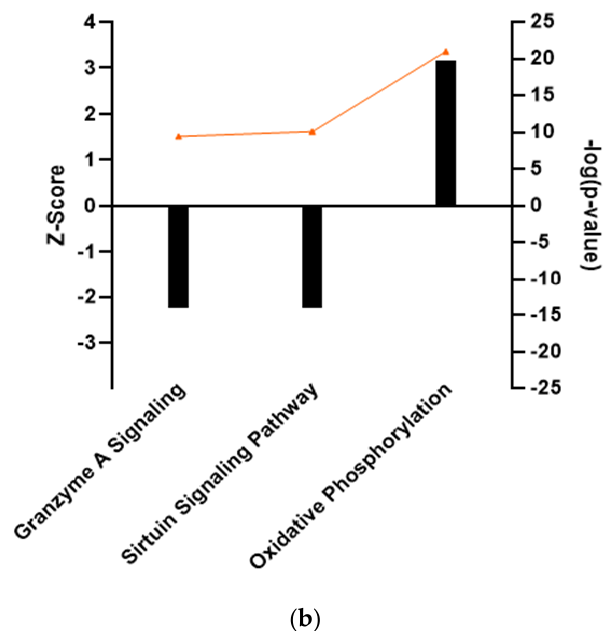
Figure 2. Ingenuity pathway analysis on HUVECs treated with DFO-sEVs. ( a ) Expression of logarithmic ratios of differentially regulated genes for treated HUVECs compared to untreated HUVECs. ( b ) Canonical pathway analysis by IPA: predicted state of activation/inhibition is displayed as Z-Score (black bars), and significance is expressed as − log10 ( p -value) (orange line).